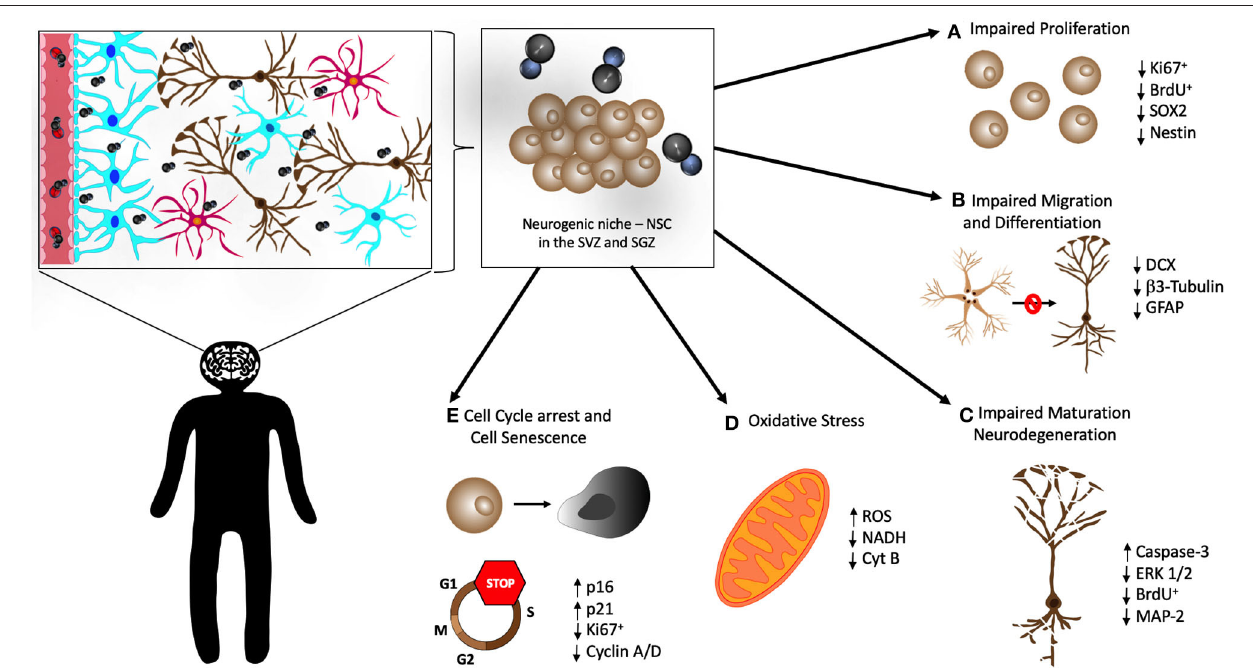
FIGURE 2 | Cellular mechanisms in the neurogenic niche that may be affected by MeHg. Once in the CNS, MeHg reaches the hippocampus and neurogenic niche in the subventricular zone (SVZ) of the lateral ventricles and the subgranular zone (SGZ) of the dentate gyrus. There are several cellular mechanisms that are believed to be altered and impaired by MeHg in neural stem cells (NSC), causing overall poor neurogenesis. There have been observations that MeHg induces (A) impaired proliferation of NSC, with a decrease of the proliferation markers Ki67 and BrdU, and of the neural stem markers SOX2 and Nestin; (B) impairment of the migration and differentiation of NSC, confirmed by the decrease of the markers DCX, β 3-Tubulin, and GFAP; (C) disruption of the maturation of new neurons and apoptosis of the existing ones (neurodegeneration), associated with elevated levels of apoptosis related proteins (Caspase-3 and ERK 1/2) and decrease of proliferation (BrdU) and neuronal markers (MAP-2); (D) increased oxidative stress, evidenced by elevation of reactive oxygen species (ROS) and decrease in NADH and Cytochrome B (Cyt B); and (E) cell cycle arrest, confirmed by the reduction in Ki67 and Cyclin A/D, and cellular senescence of NSC, concomitant with the elevation of the expression of p16 and